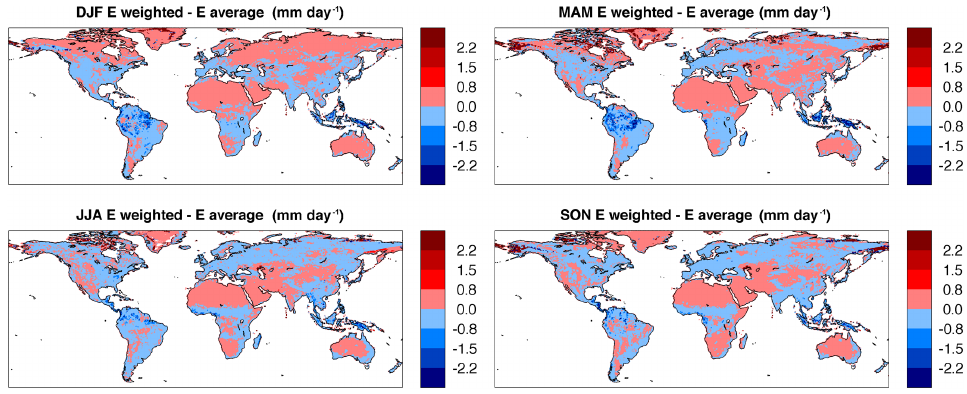
Figure 9. Seasonally averaged normalized ET differences between SA-merger and WA-merger, expressed as a percentage of the seasonally averaged SA-merger ET. Red (blue) colours indicate positive (negative)